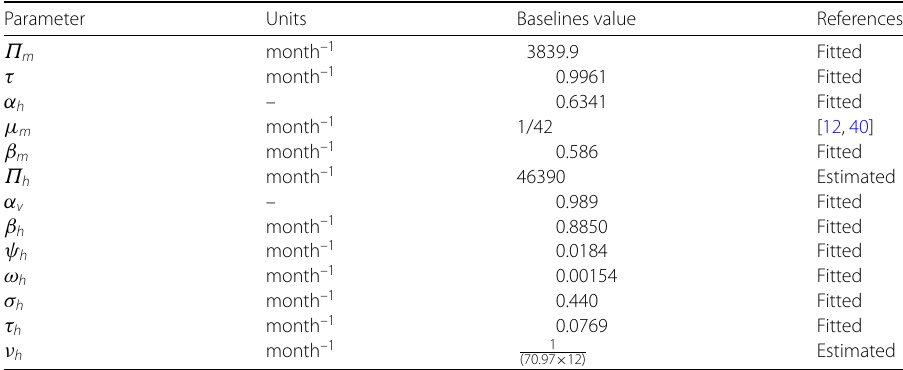
Table 2 Fitted and estimated values for the parameters of the model (10)